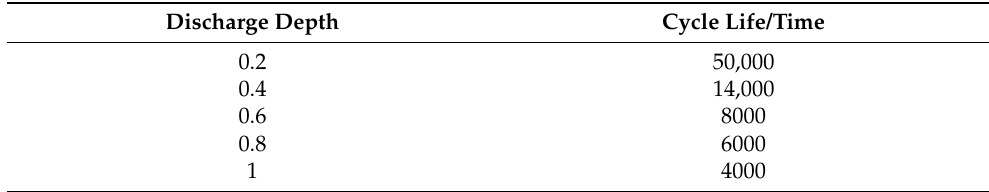
Table 3. Relationship between the depth of discharge of a lithium battery and its cycle life.